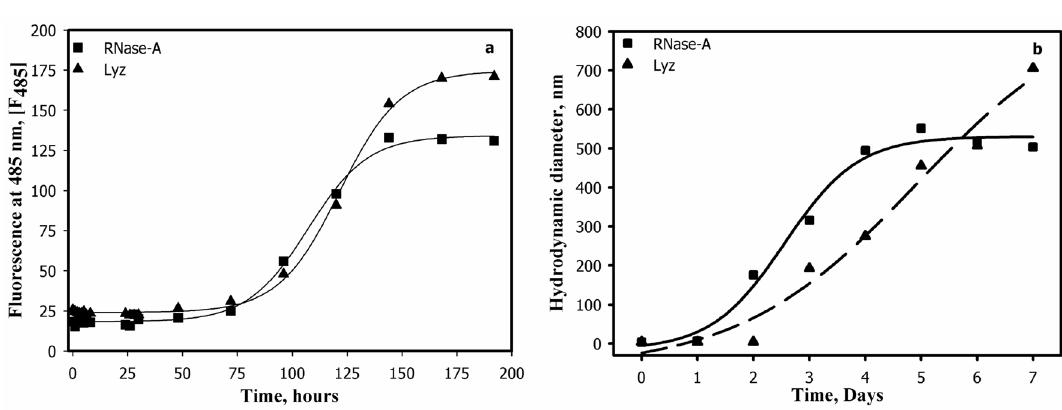
Figure 2. Aggregation kinetics profiles of HTL-modified proteins: Time-dependent aggregation curves of HTL- modified RNase-A and Lyz (Panel a ) taken at intervals of 24 h monitored using ThT dye. HTL concentration was kept constant at 1000 µM for all the experiments. Panel ( b ) represents the aggregation kinetic curve of HTL-modified RNase-A and Lyz obtained by plotting hydrodynamic radii versus time using values obtained from Table